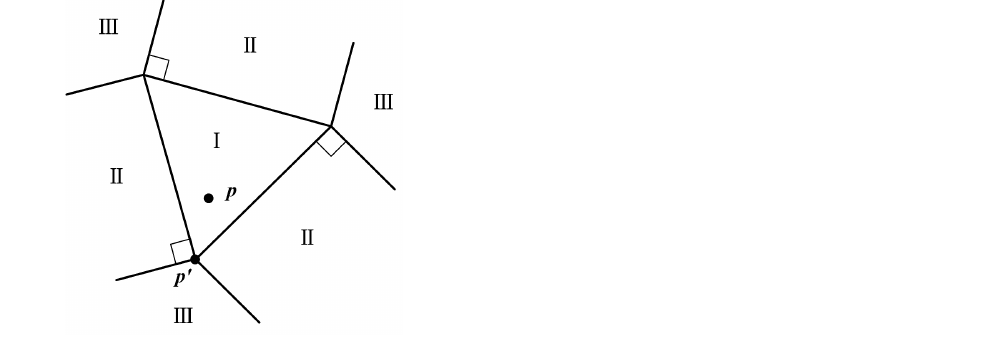
Figure 6. Judgment of distance from near point to burning surface. Regions I–III represent three cases of projection of grid nodes to the nearest burning surface triangle element .